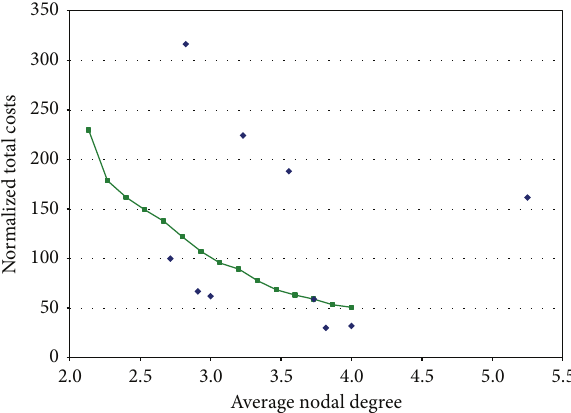
Figure 21: Normalized SBPP JCA total capacity